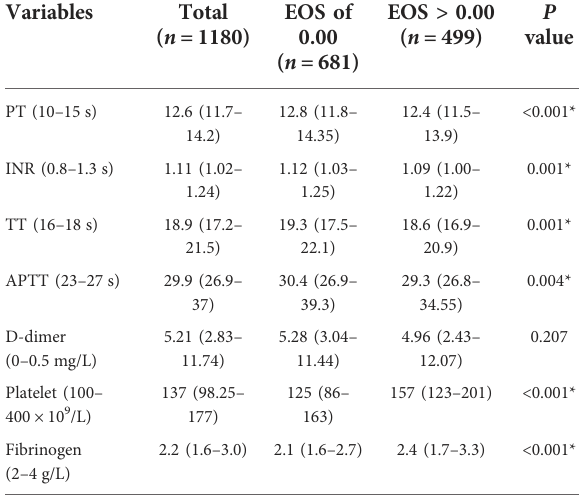
TABLE 6 Five blood coagulation items in both eosinophil